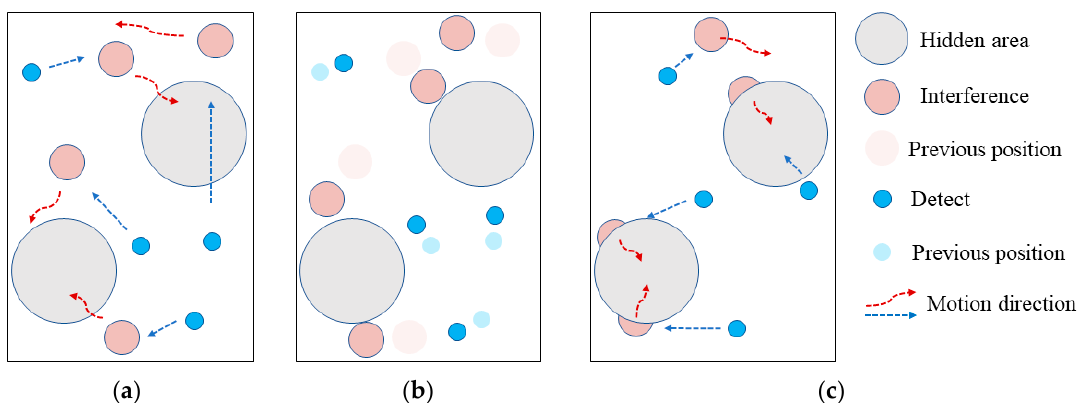
Figure 10. Multi-agent covert confrontation environmental confrontation process diagram: ( a ) motion trend of the detection agent and the interference agent; ( b ) action of the detection agent and the interference agent; ( c ) action process of the detection agent and the interference agent.